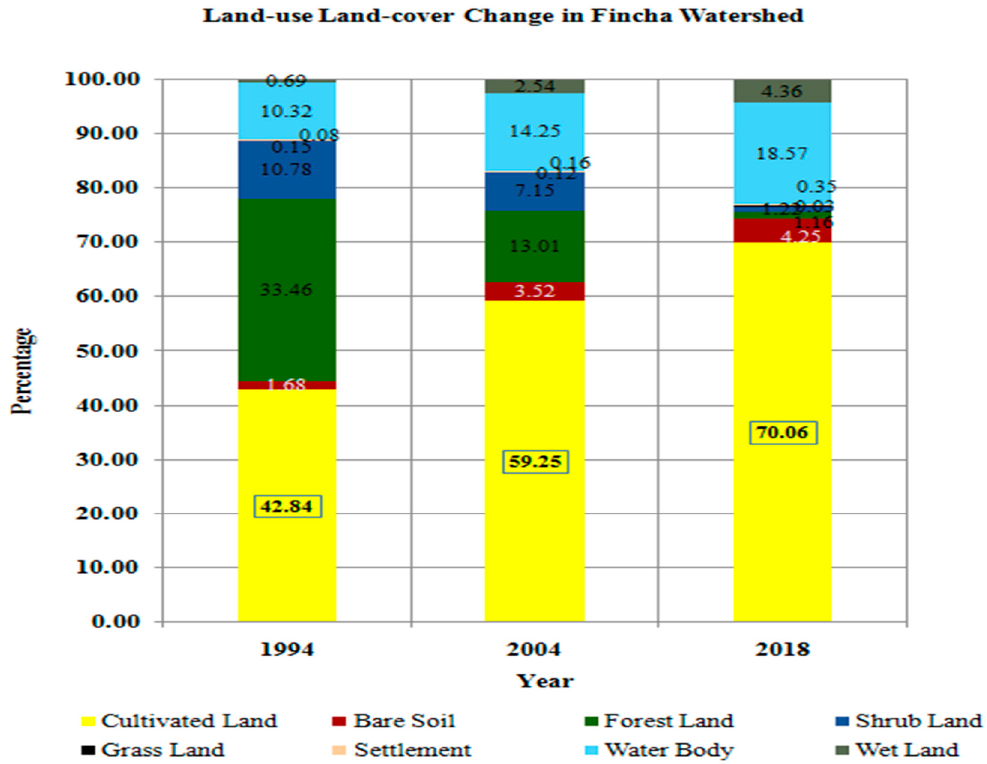
Figure 10. Percentage of LULC distribution in Fincha’a watershed in the three reference years.